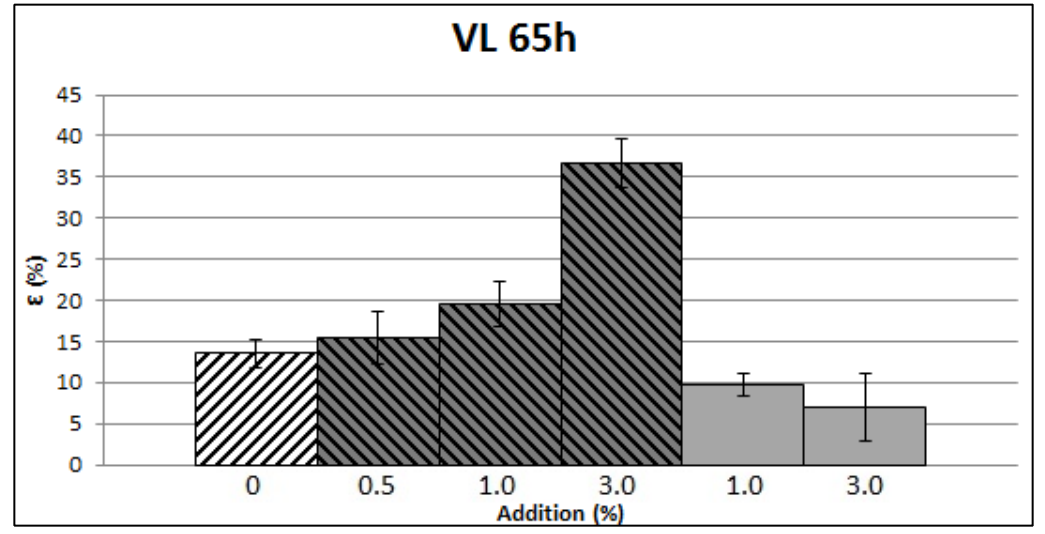
Figure 6. Photocatalytic efficiency Coefficient ( ε ) for samples in Visible light with 1%, 3% TiO 2 − x N y and 1%, 3% TiO 2 for samples at 65 h of curing age, control sample, TiO 2 − x N y , TiO 2 . Errors bars are standard